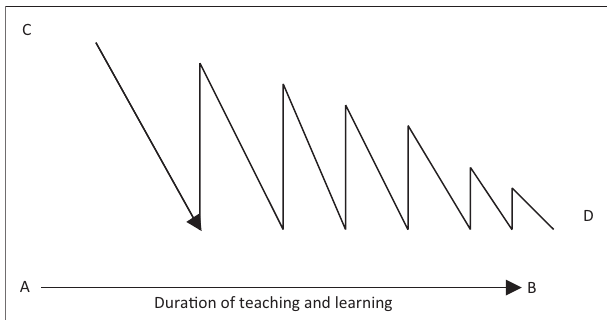
FIGURE 1: Gradual accommodation of code switching in Afrikaans second